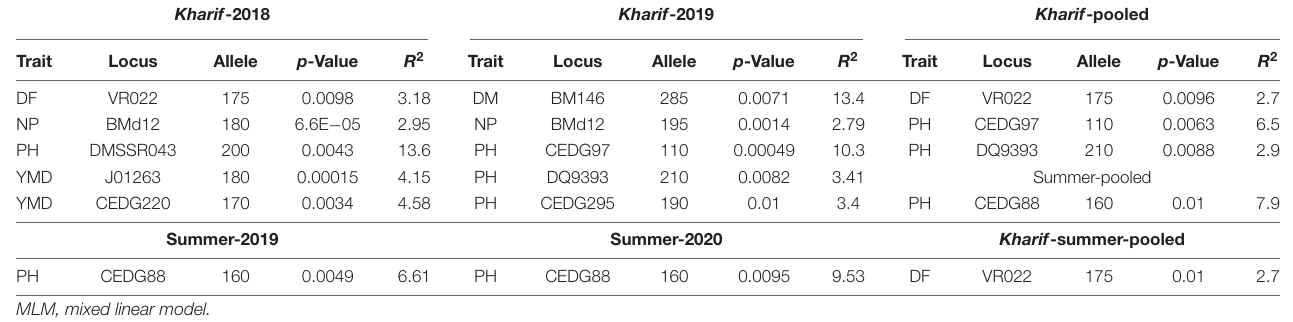
TABLE 8 | Significant marker-trait associations identified from MLM (Q + K) approach in different environments.